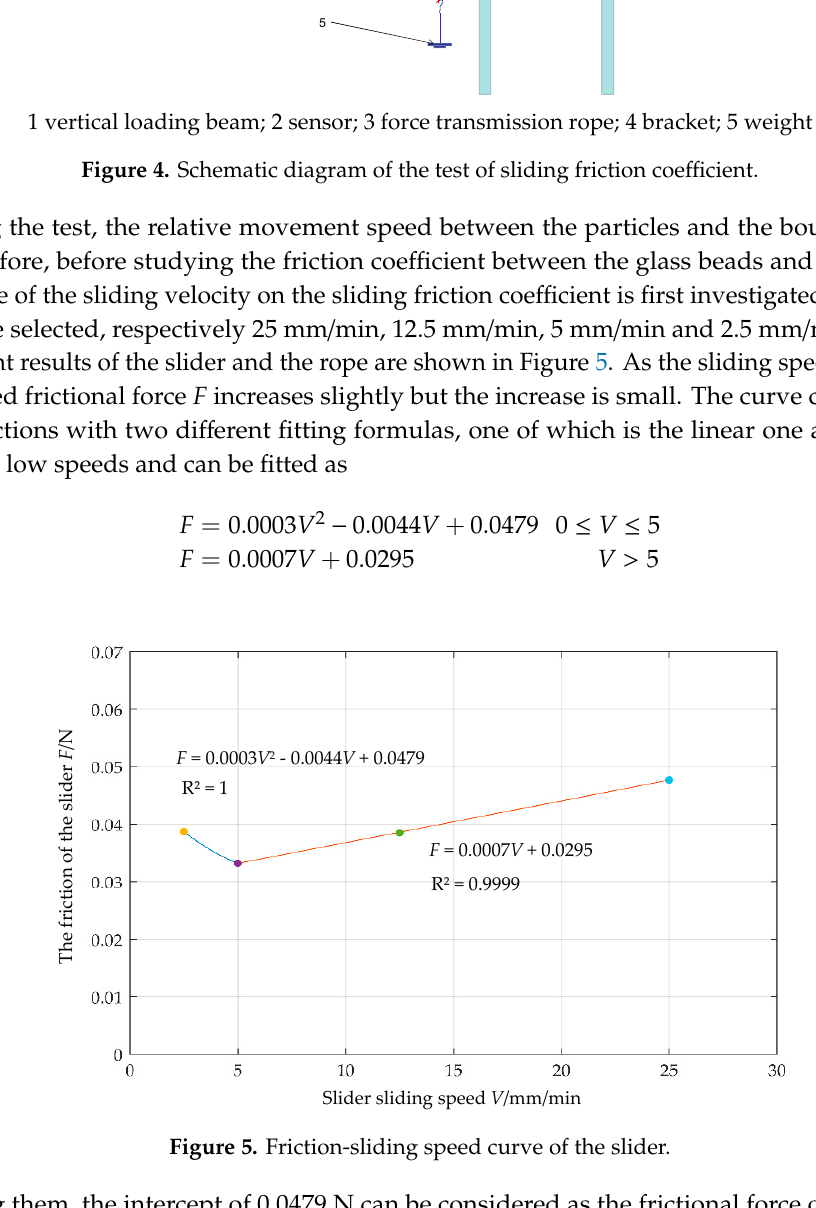
Figure 5. Friction-sliding speed curve of the slider.